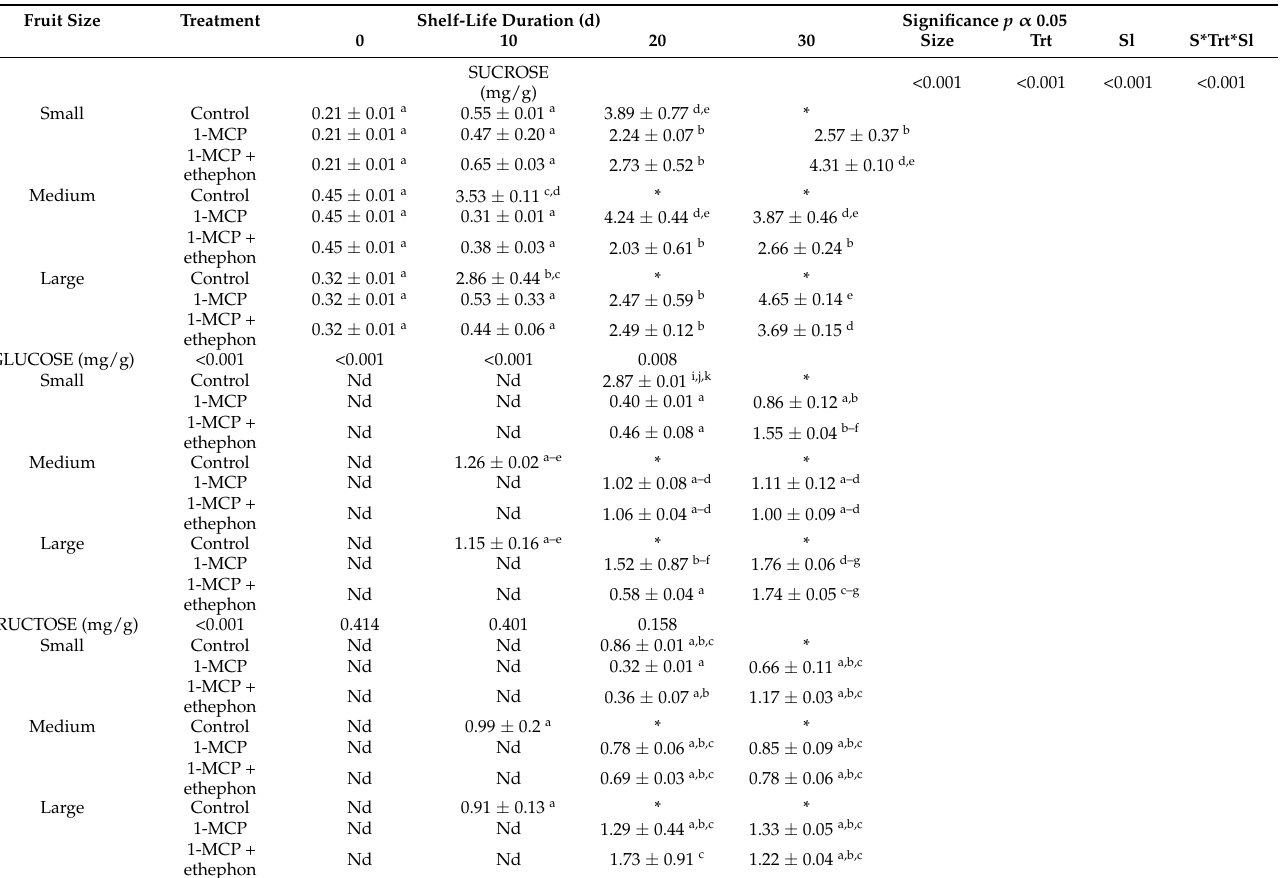
Table 3. Effect of fruit size, 1-MCP, treatments and shelf-life duration and their interaction on sucrose, glucose, and fructose concentration at ambient temperature.